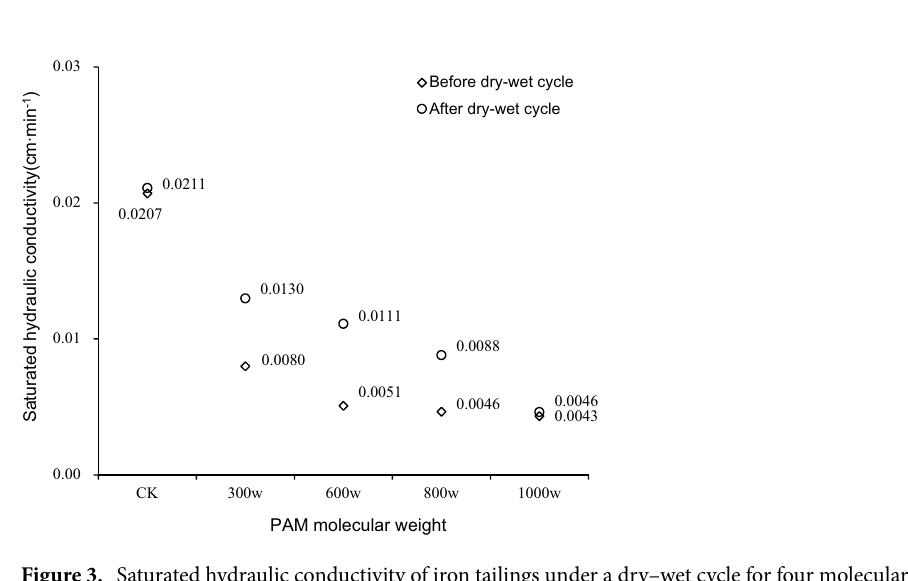
Figure 2. Saturated hydraulic conductivity of iron tailings for four molecular weight (300w, 600w, 800w and 1000w) and five mass concentration (0%, 0.01%, 0.04%, 0.08% and 0.16%) of PAM.